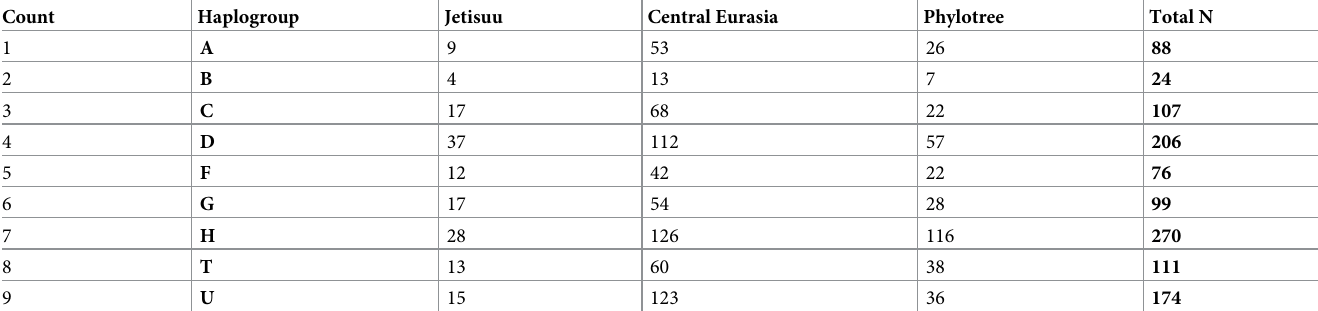
Table 4. Central Eurasian mtGenomes analyzed together with phylotree mtGenomes.